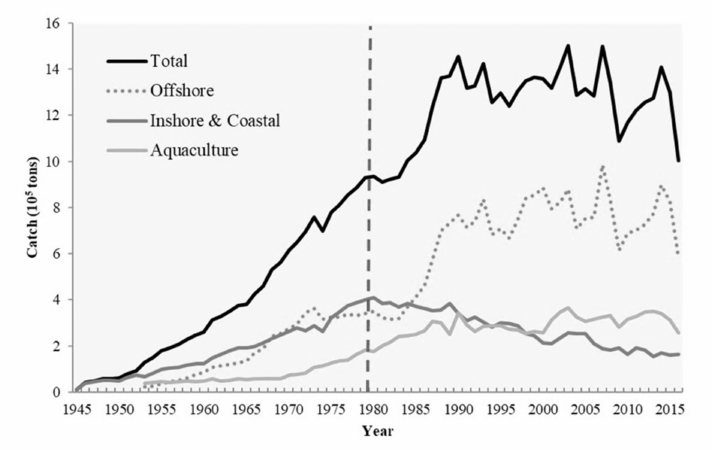
Figure 2. Average annual catch of Taiwan Fishery from 1945 to 2017. The black line, dotted line, dark gray line and light gray line represent the total, offshore, inshore and coastal, and aquaculture fishery, respectively (Fisheries Agency,